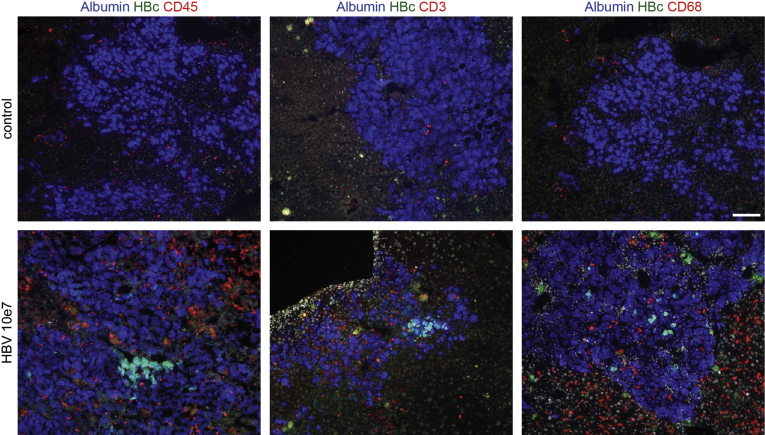
Immunofluorescence analysis of liver sections from HIS-HUHEP control or low-dose (HBV 10e7) infected mice co-stained for hAlbumin (blue) and HBc (green), with either hCD45 (red), or hCD3 (red), or hCD68 (red). DAPI-stained nuclei shown in grey. Scale bar represents 100 μm.